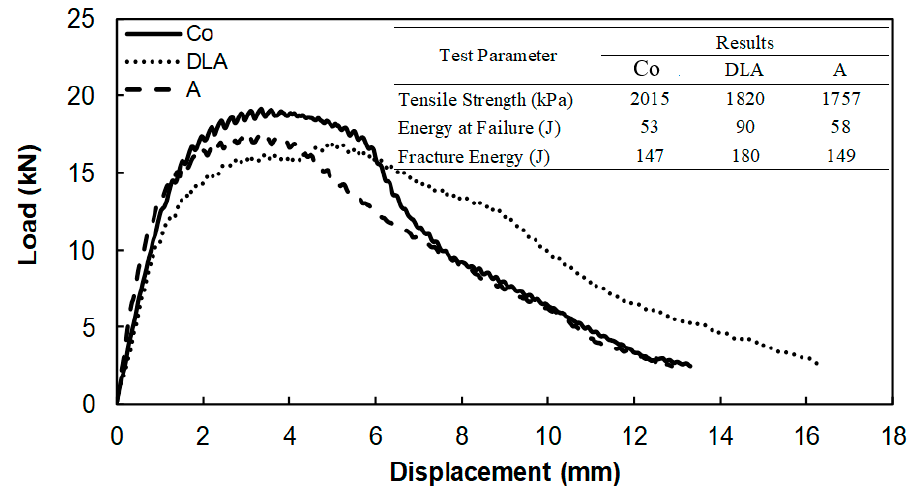
Figure 11. Comparison of IDT test results for unconditioned mix (Co) and conditioned mixtures (DLA and A).